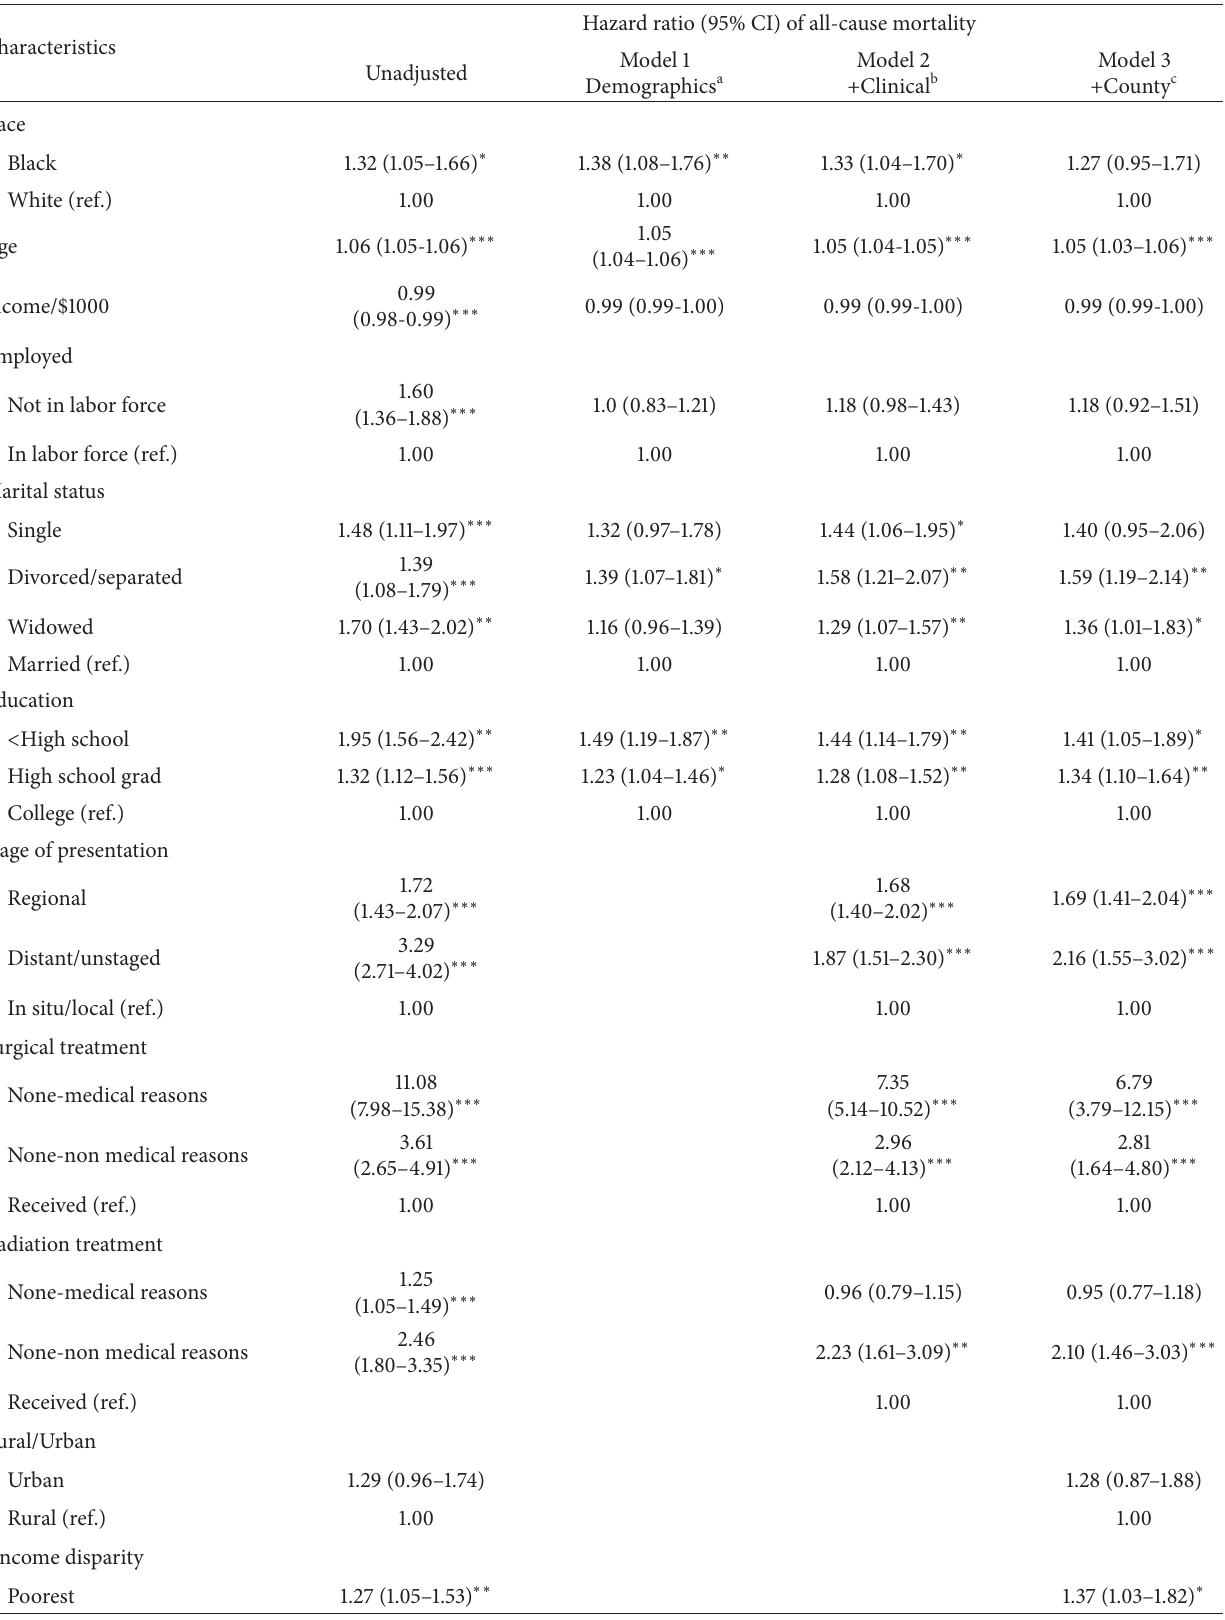
Table 4: Cox Proportional Hazard analysis of all-cause mortality, SEER-NLMS,